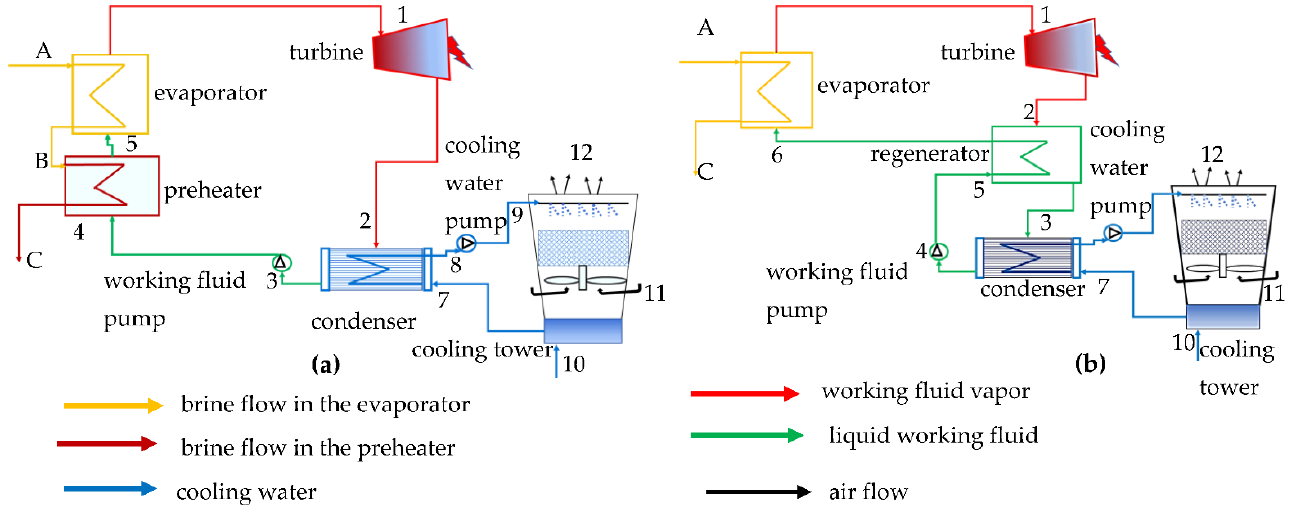
Figure 2. Proposed basic binary units designed and analyzed using EES code, ( a ) simple ORC cycle; ( b ) regenerative ORC cycle without preheater.